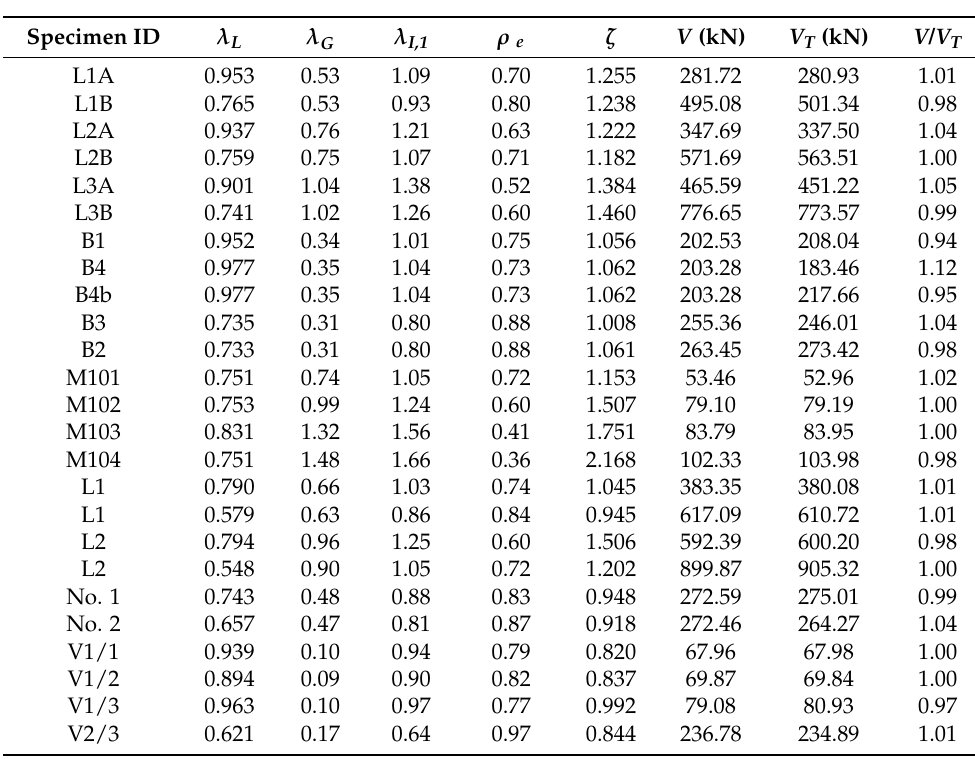
Table A10. Analysis results of test specimens reported by Lindner and Aschinger